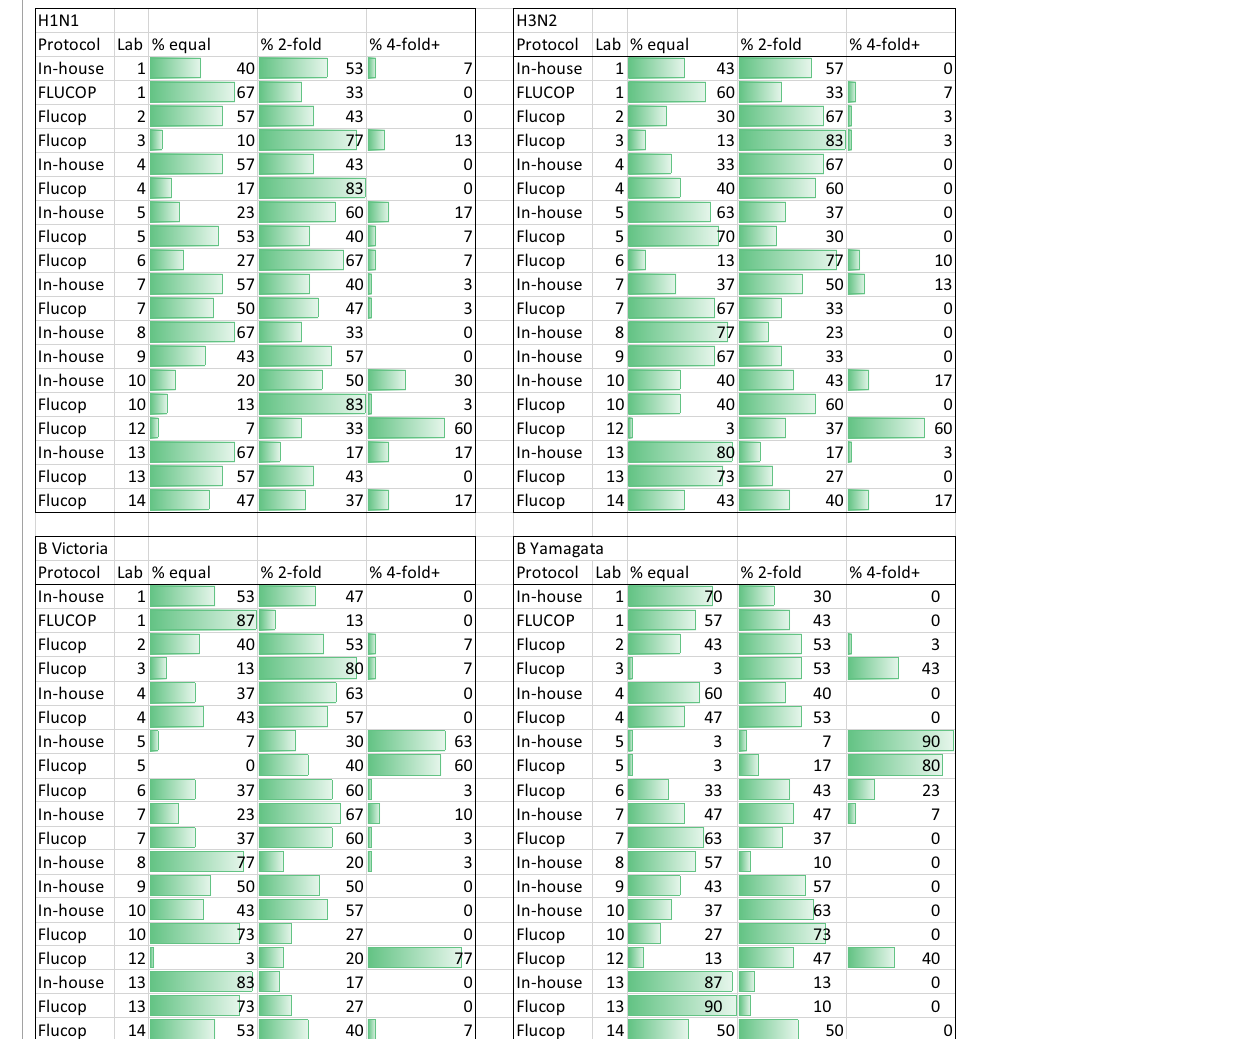
TABLE 1 HAI Intra-laboratory variation - % of maximum to minimum titre ratios across at least 2 replicates that =1, = 2, or ≥ 4. H1N1 H3N2 Protocol Lab % equal Protocol Lab %